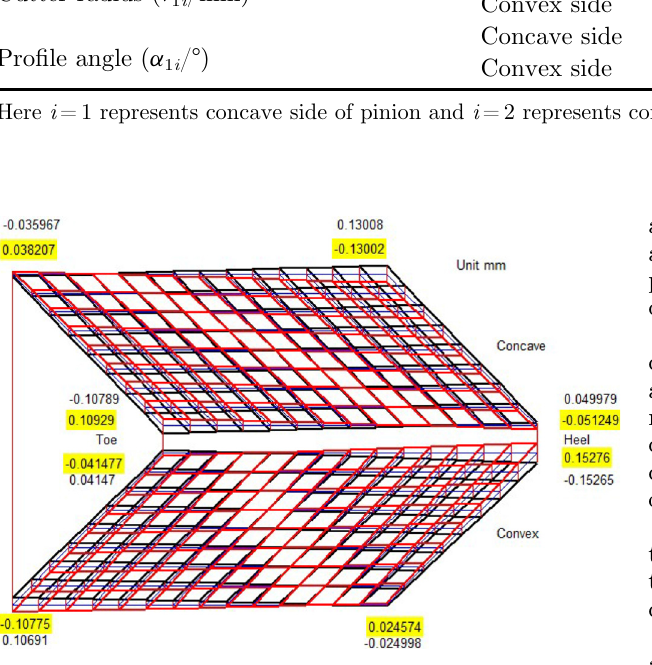
Fig. 6. In fl uence of helical motion on tooth surface